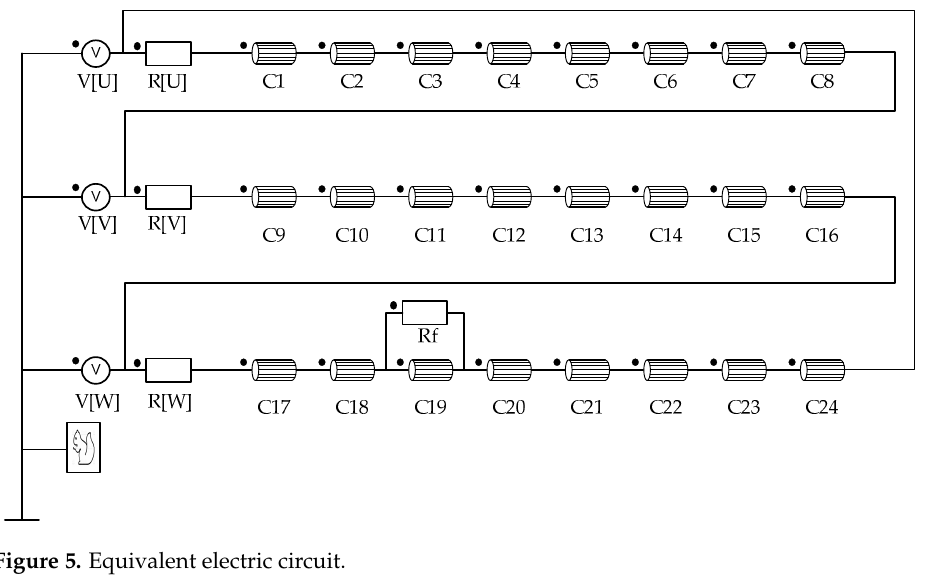
Figure 4. Transient electromagnetic application flowchart.